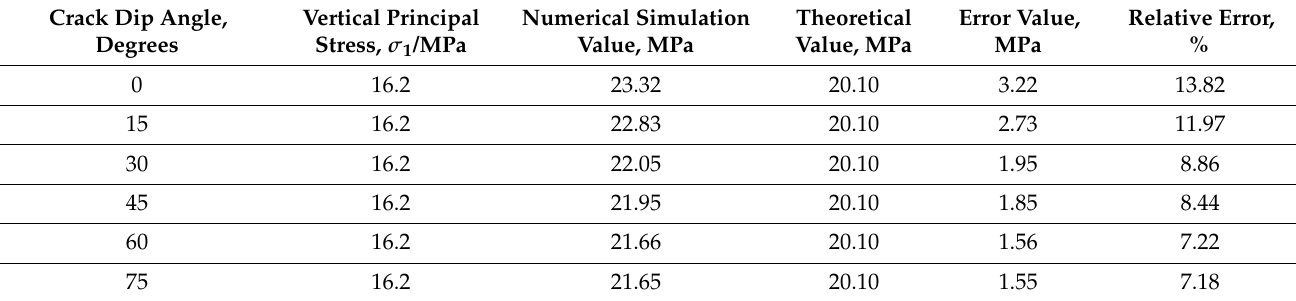
Table 4. Comparison of grouting pressure under different overlying rock densities.